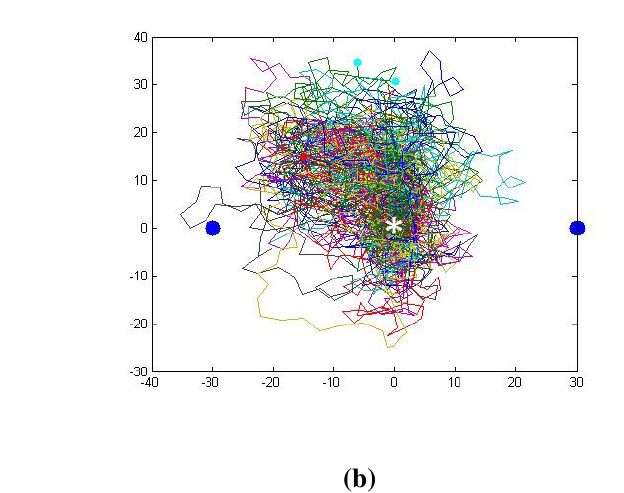
Figure 9. Case 2 simulation results showing 100 trials of two different noise conditions. The theoretical optimum (*) is at the center (0,0). ( a ) LOS scenario with 1 dBm spatio-temporal Gaussian noise in RSS; ( b ) LOS scenario with 1 dBm spatio-temporal Gaussian noise in